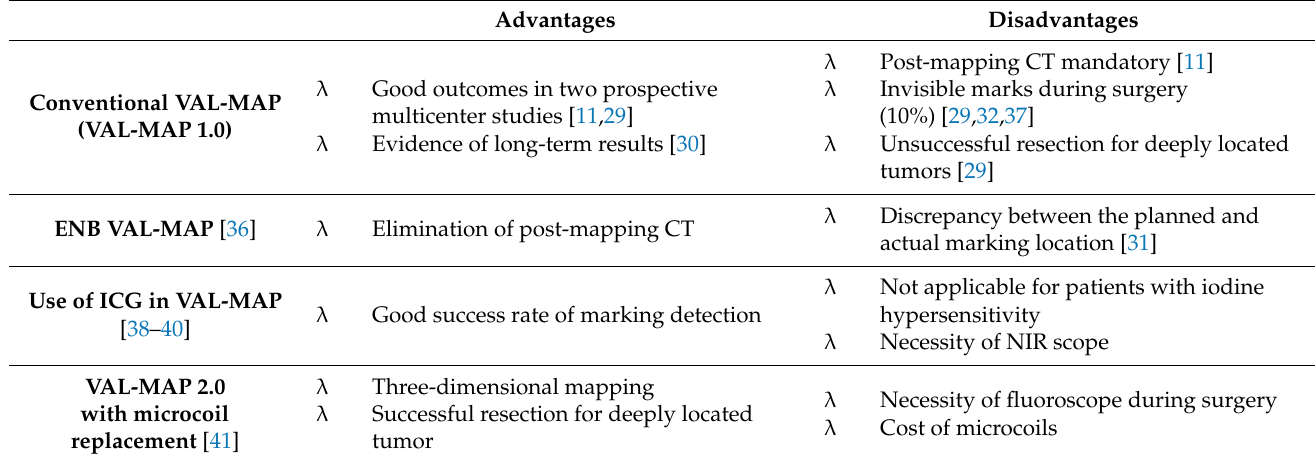
Table 2. Advantages and disadvantages of each virtual-assisted lung mapping